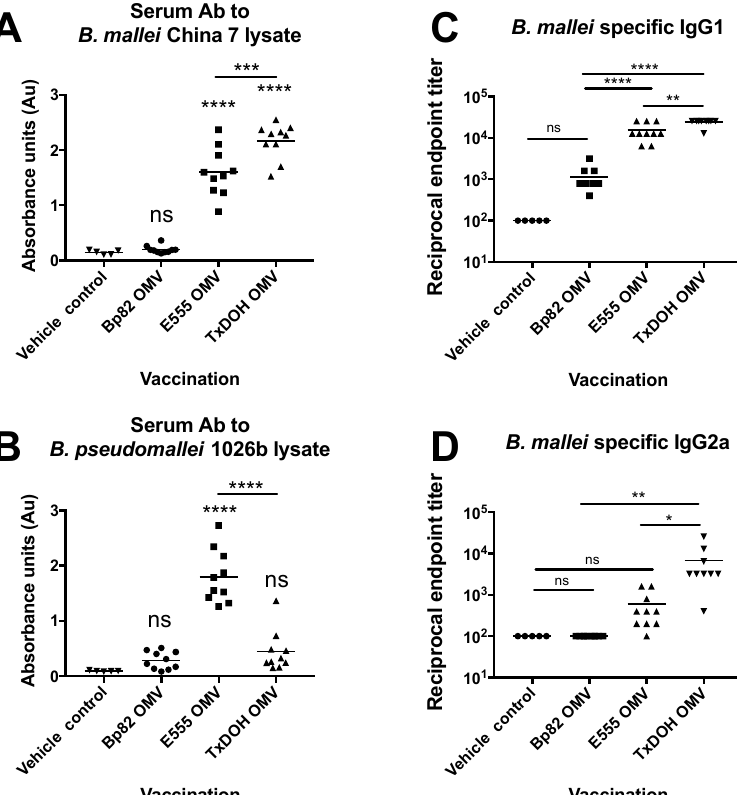
Figure 4. Biosafe strain-derived OMVs produce B. mallei and B. pseudomallei specific serum antibody responses. ( A ) Serum antibody responses in vehicle only or OMV-vaccinated mice (PBS n = 5, all others n = 10) to B. mallei China 7 lysate. ( B ) Serum antibody responses in vehicle only or